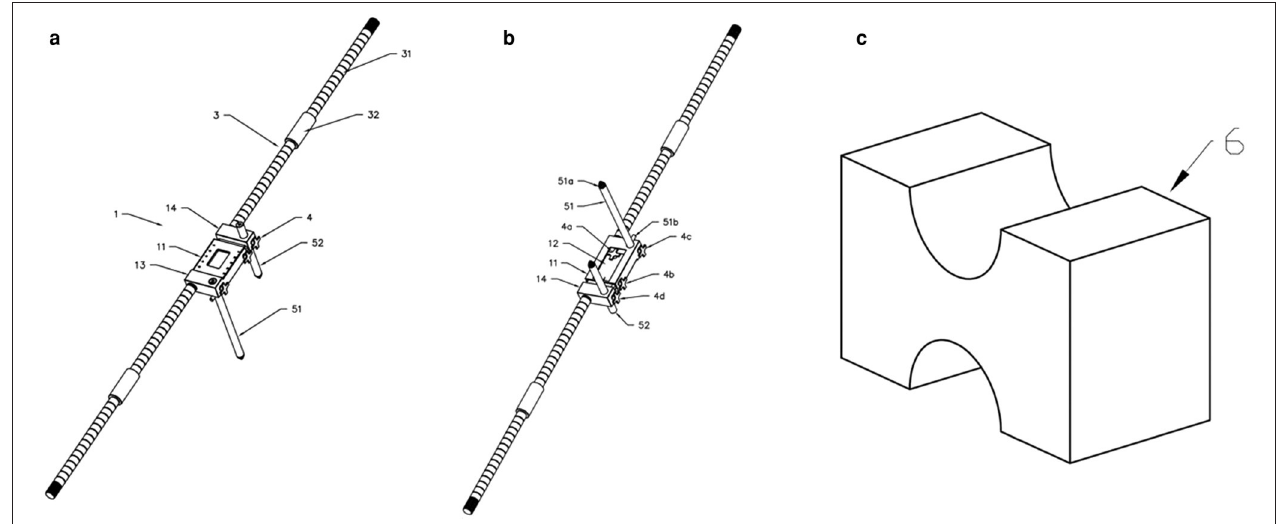
FIGURE 3 | Structure diagram of the horizontal calibrator (a) is the front structure diagram of the horizontal calibrator, and (b) is the reverse structure diagram. 1—Sliding Scale, 2—Bubble Level, 3—Extension Rod, 4—Lock Screw, 5—Steinman pin, 6—Limb Fixture; 11—first main ruler, 12—second main ruler; 13—First connecting part, 14—Second connecting part;111 − 0–6cm ruler scale, 112—rectangular groove, 113—open accommodating groove, 114-lock hole; 121 − 6–12cm ruler scale, 122—lock hole groove; 131—first horizontal hole groove, 132—first three-way hole; 141—second horizontal hole groove, 142—second three-way